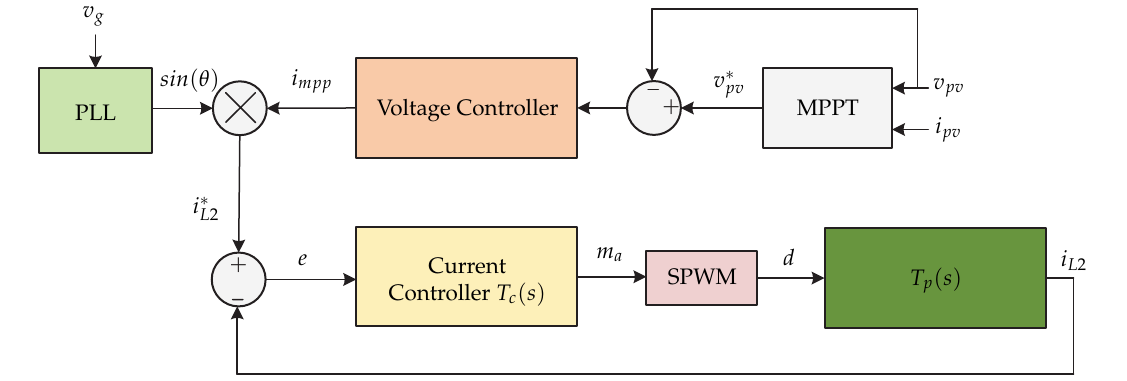
Figure 9. Control strategy proposed in [18].